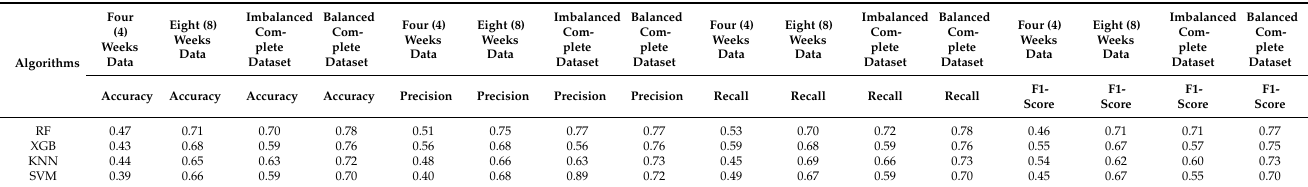
Table 6. Comparison of ML classification algorithms based on different performance indicators